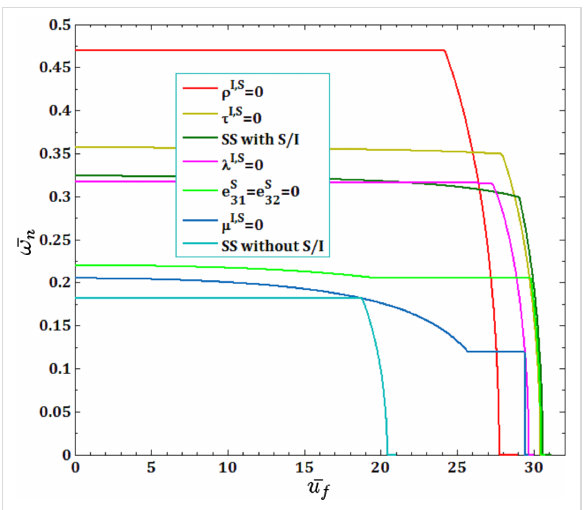
stiffness, and as a result, the DNF and pull-in voltage increase and critical fluid velocity decreases. Increasing the surface/ interface mass density, ρ I,S , due to increasing